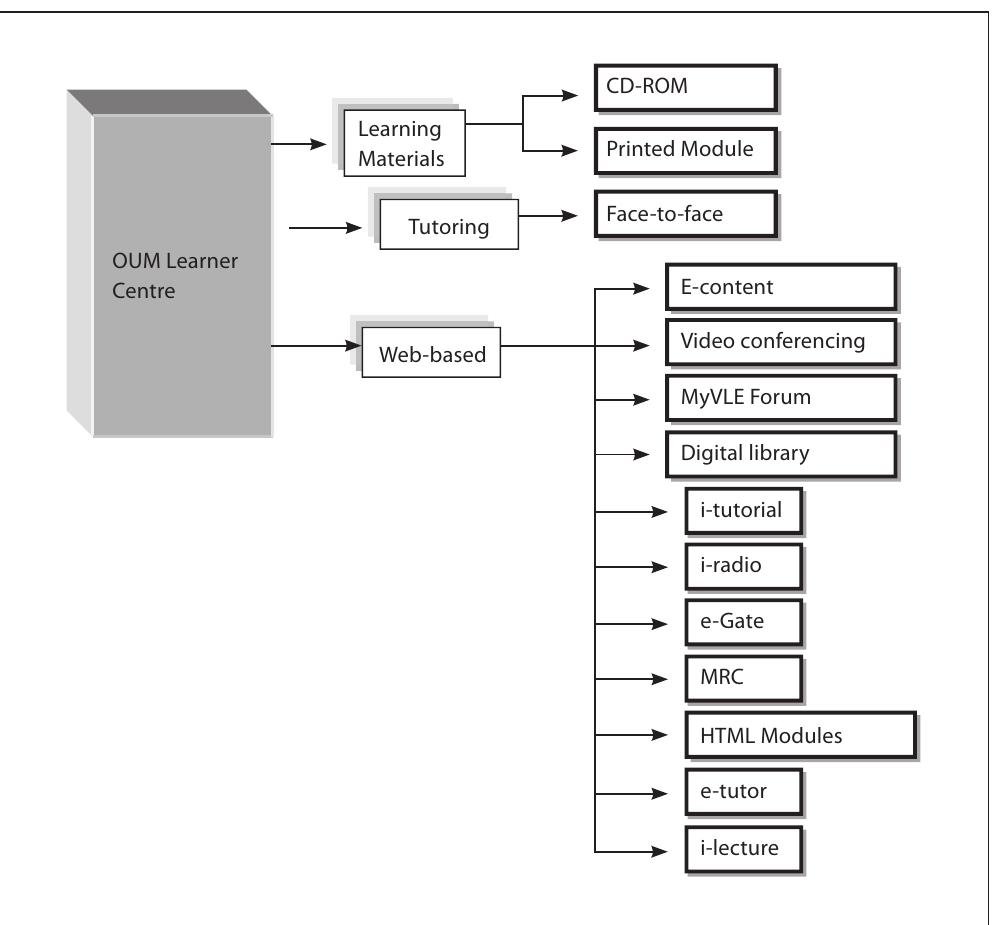
Figure 1 The current ODL model of OUM Source: OUM Portal